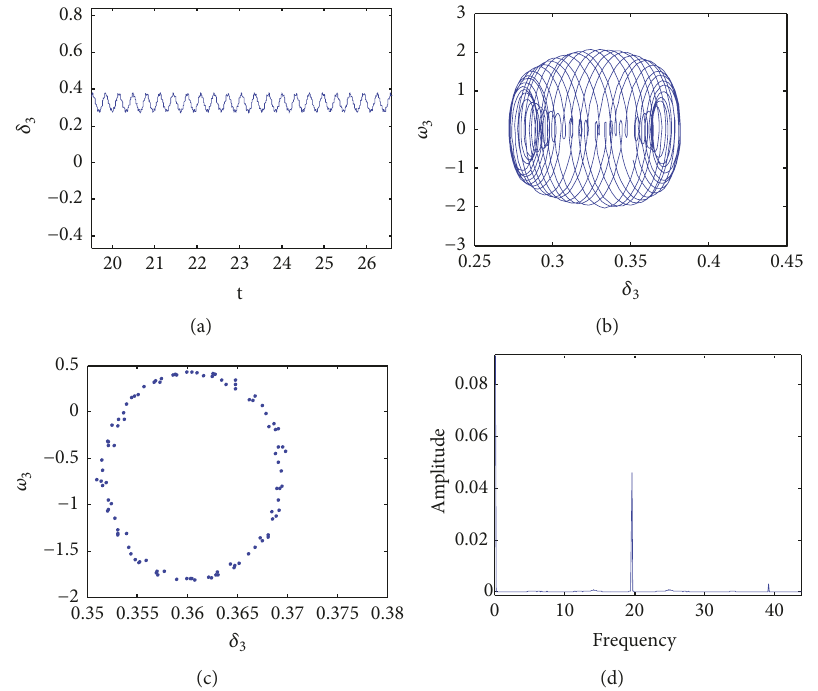
Figure 20: Quasi-periodic motion ( 𝑉 𝐵1 = 0.7). (a) Time history. (b) Phase portrait. (c) Poincar´e map. (d) Frequency